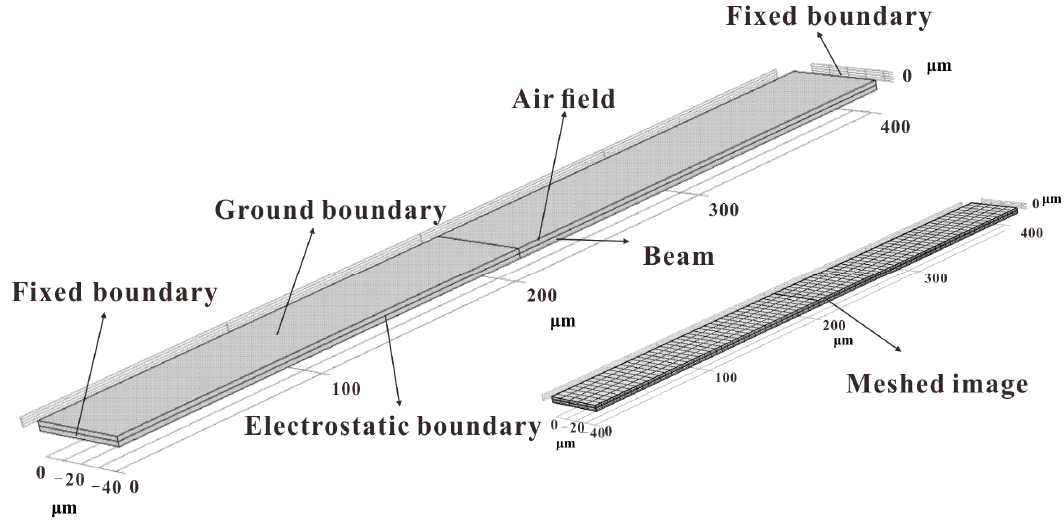
Figure 12. COMSOL simulation model.